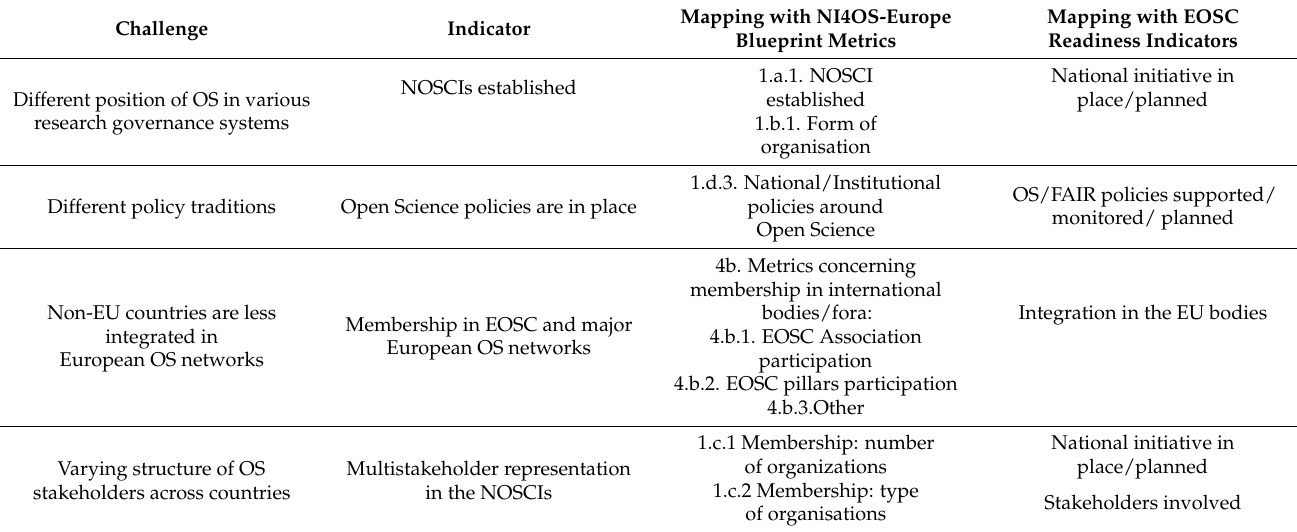
Table 5. The challenges to scholarly communication in the NI4OS-Europe countries and the mapping between the impact indicators for scholarly communication and the NI4OS-Europe Blueprint metrics and EOSC readiness